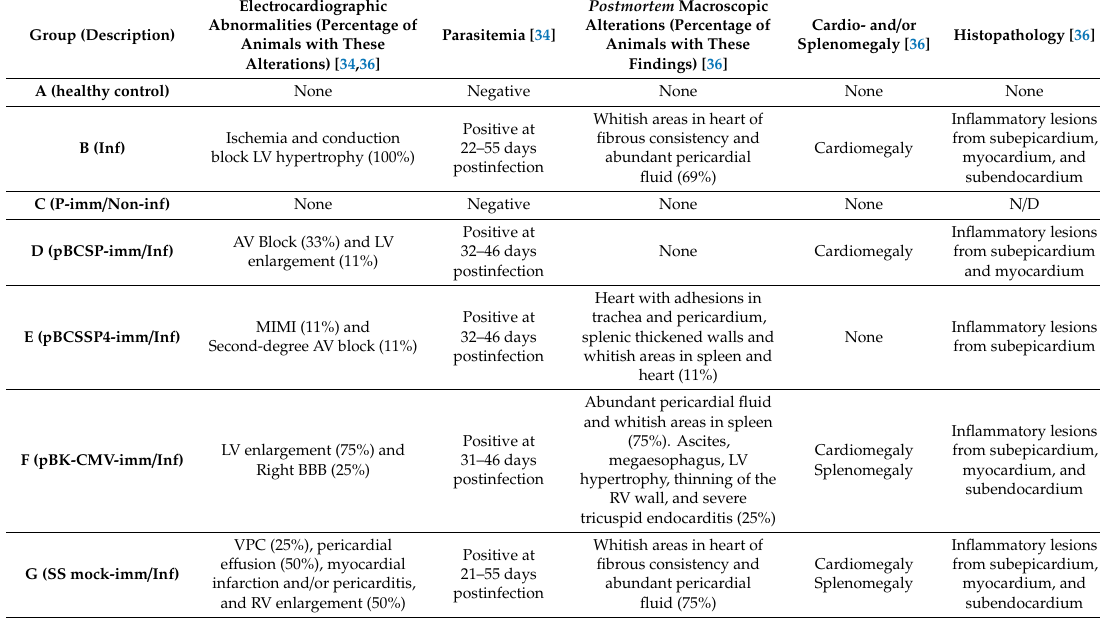
Table 3. Other findings obtained previously in the same T. cruzi experimentally infected dogs immunized with DNA vaccine containing the genes encoding a trans -sialidase protein (pBCSP) or an amastigote-specific glycoprotein